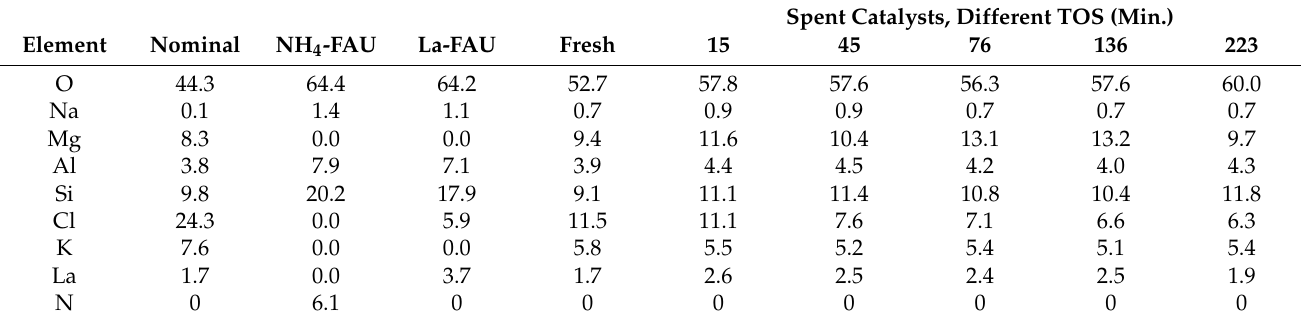
Table 3. Chemical composition of S-ACl catalyst measured by energy-dispersive X-ray spectroscopy (EDX) based on the atomic percentage (at. %) of elements.